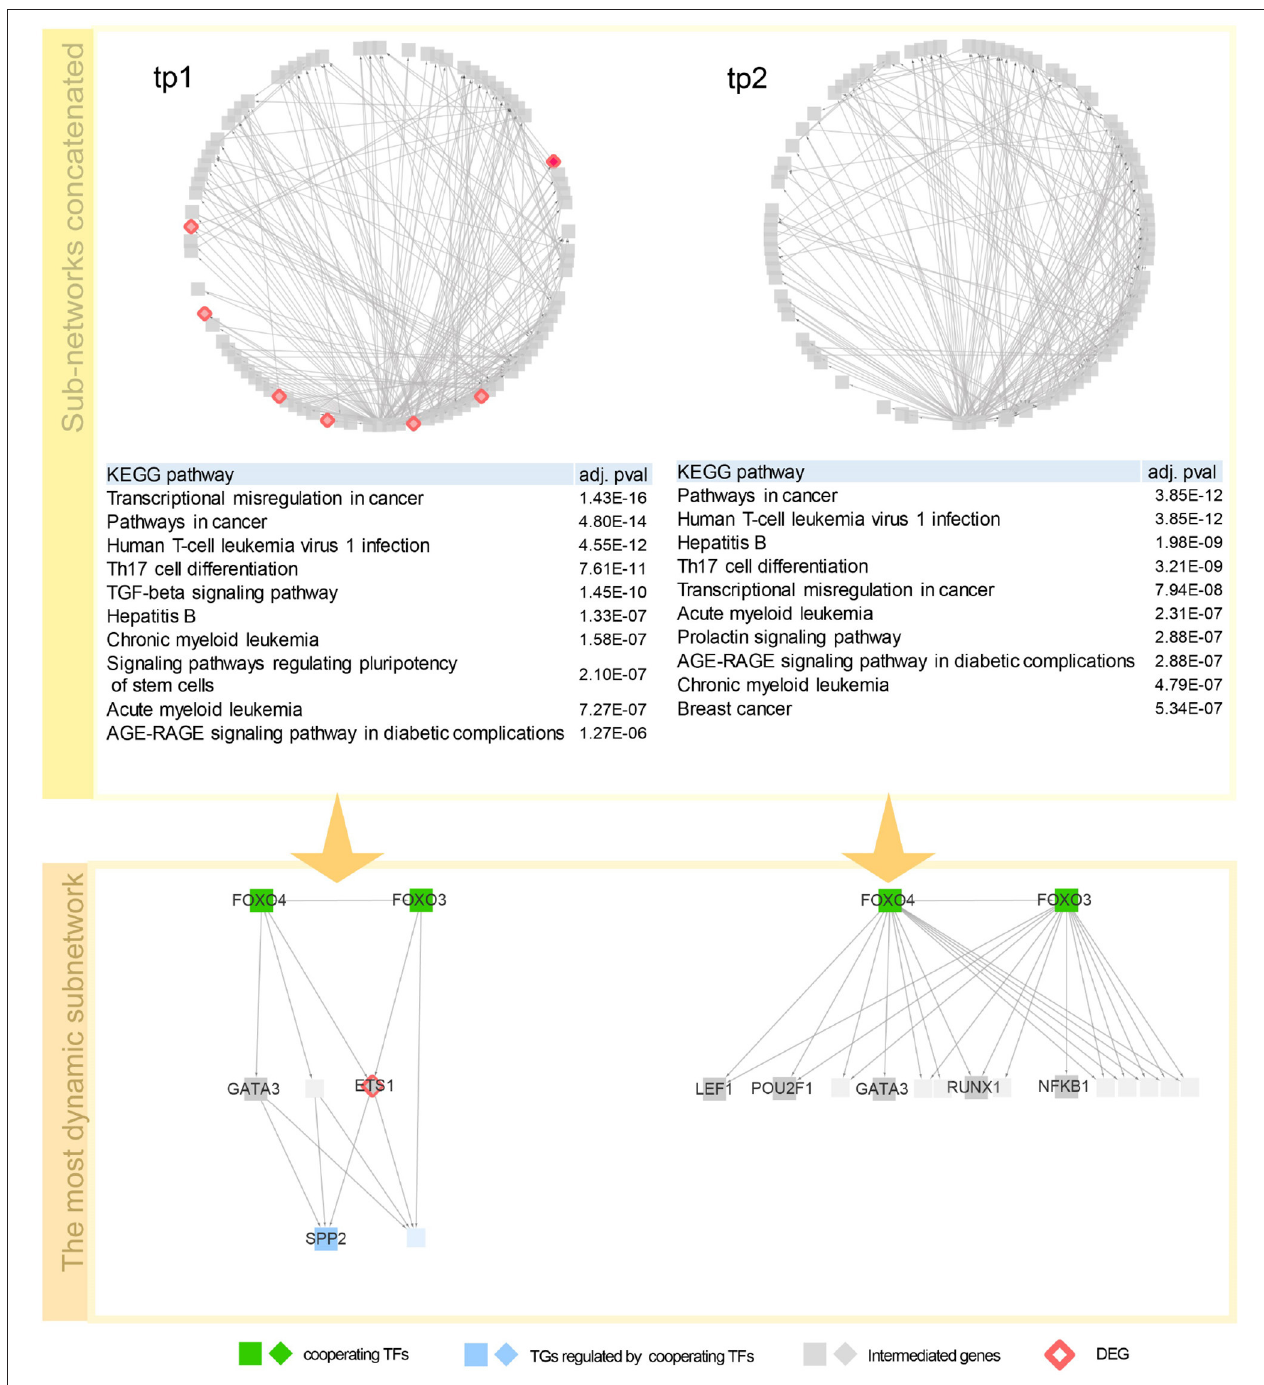
FIGURE 2 | Network dynamics of a gene regulatory network (GRN) sub-network after high-fat meal (HFM) over time. Two circular diagrams in the upper panel show the change in gene–gene relationship, in particular, TF–TG regulation. Two tables in the middle summarize top 10 most enriched biological pathways with p -value corrected by false discovery rate (FDR) < 0.05. Two networks are dynamics of a TF–TG sub-network with the highest dynamics score. In the TF–TG sub-network, two transcription factors (TFs), FOXO3 and FOXO4, regulates different sets of target genes (TGs) over time. TFs were denoted with diamond-shaped nodes. Square nodes denotes TGs and circle nodes denote genes connected to TFs and TGs. Nodes colored pink denote genes that consist of GRN in each time point. Nodes colored red denote shared TFs among concatenated sub-networks and nodes colored green DEGs that are detected by DESeq with FDR < 0.05.